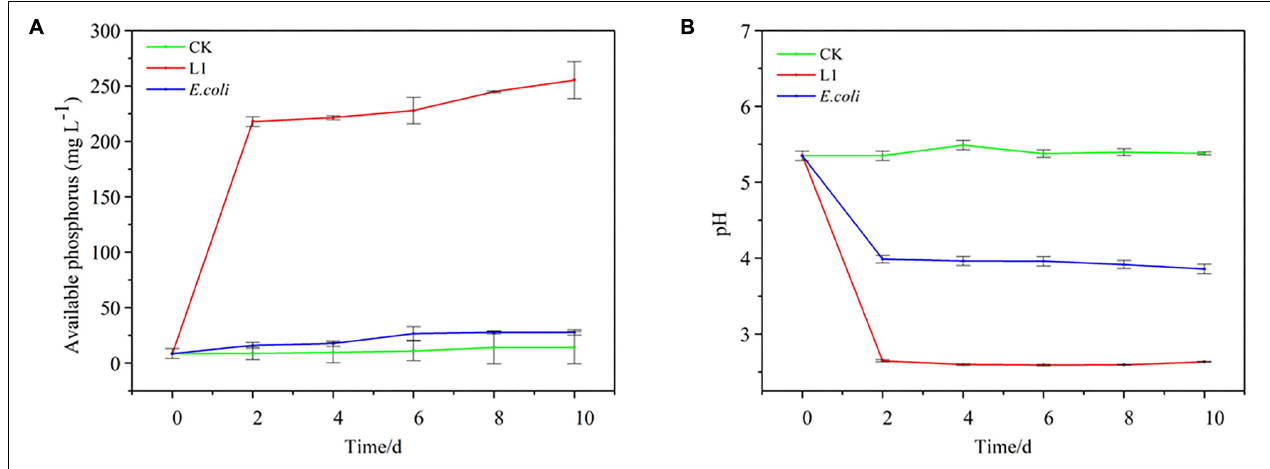
FIGURE 2 | Aluminum-phosphate solubilizing abilities of Nguyenibacter sp. L1. (A,B) Available P concentration (A) and pH (B) of the culture medium after culturing Nguyenibacter sp. L1 with AlPO 4 as the P source at 30 ◦ C for 0, 2, 4, 6, 8, and 10 days. An Escherichia coli strain and sterile water (CK) were included as controls. Vertical bars represent standard deviations of the means ( n =